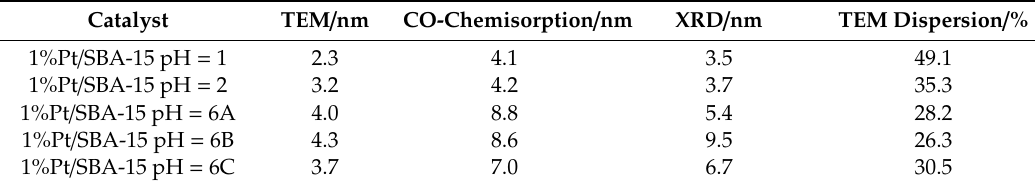
Figure 3. ( A ) XRD patterns and ( B ) N 2 sorption isotherms of 1%Pt-SBA-15 catalysts prepared under di ff erent conditions. Table 1. Particle sizes of Pt on Pt / SBA-15 catalysts calculated by di ff erent methods.